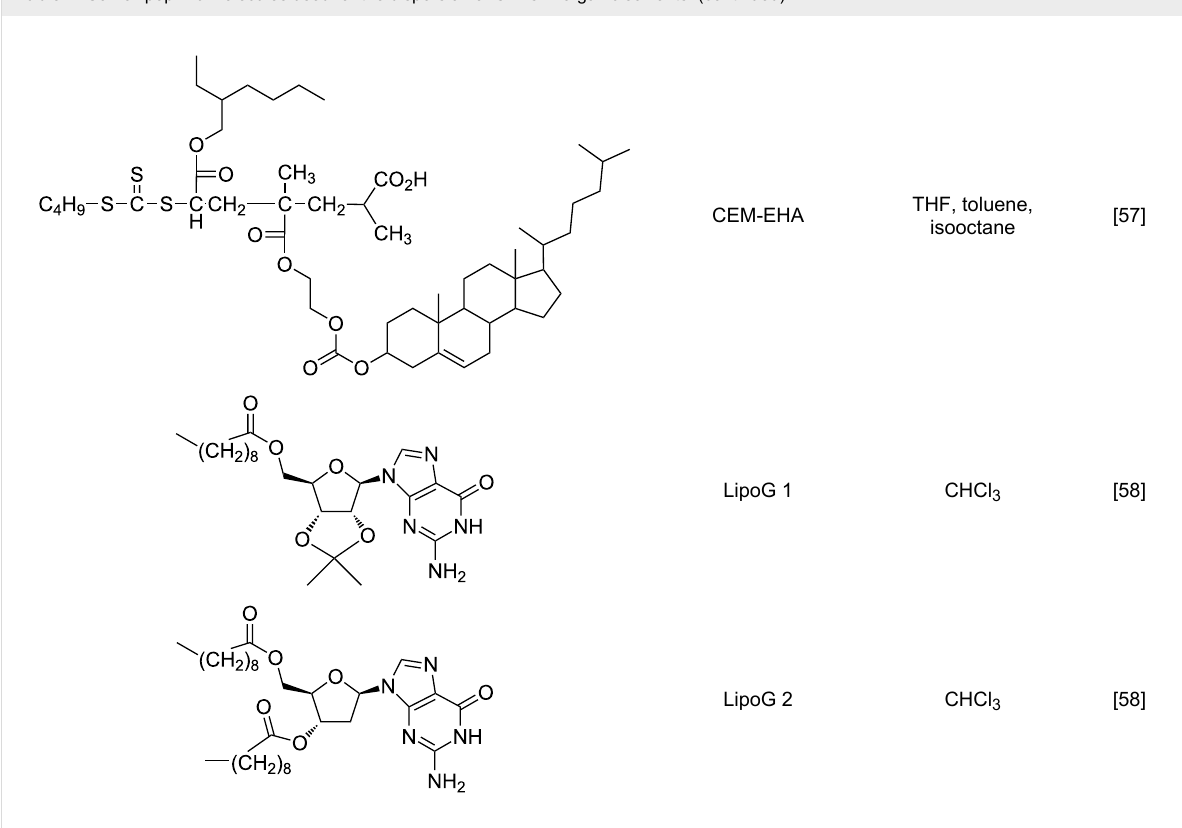
Table 1: Some lipophilic molecules used for the dispersion of CNTs in organic solvents.